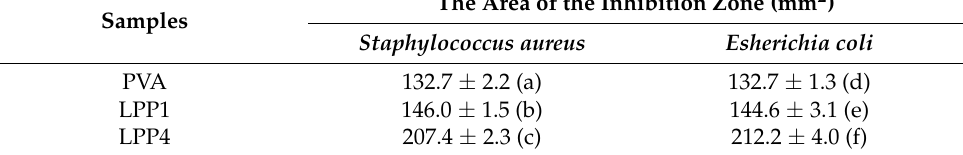
Figure 8. Thermal stability of films of PVA, LPP, CPP. ( a ) TG curves of the films; ( b ) DTG curves of the films; ( c , d ) DSC curves of thin films. the films; ( c , d ) DSC curves of thin films. Table 1. Antibacterial activity of different films. Table 1. Antibacterial activity of different films.